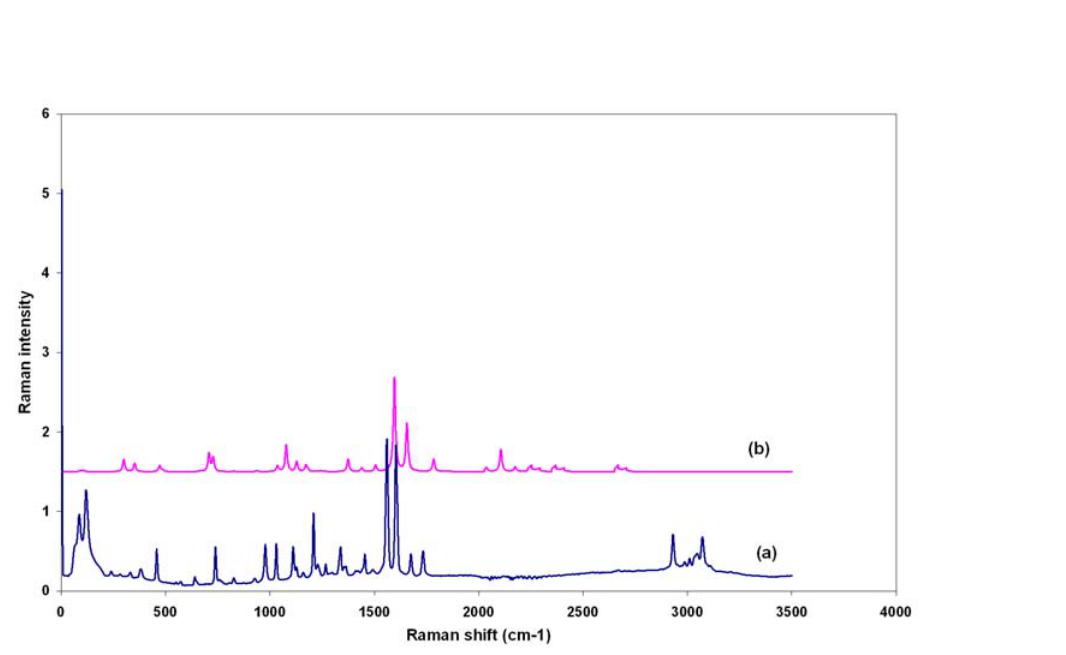
Fig. 3 FT-Raman spectra of acetyl coumarin; (a) experimental, (b)